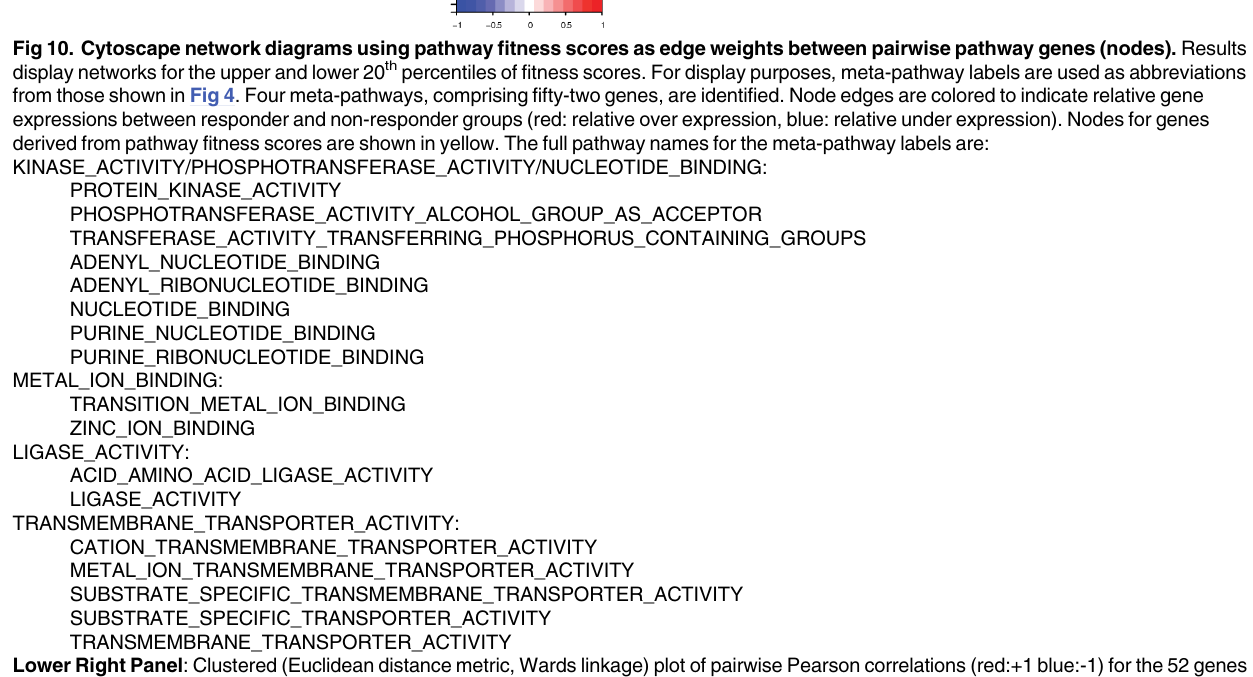
PLOS ONE | https://doi.org/10.1371/journal.pone.0181991 August 8,